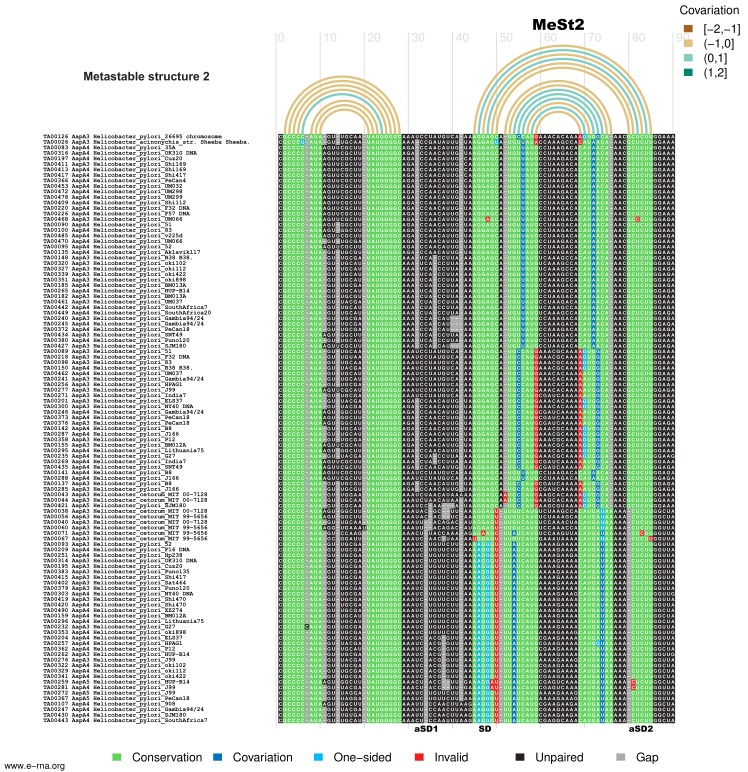
Structural alignment and covariation analysis ofaapA3mRNA nascent transcript of 80 nucleotides.